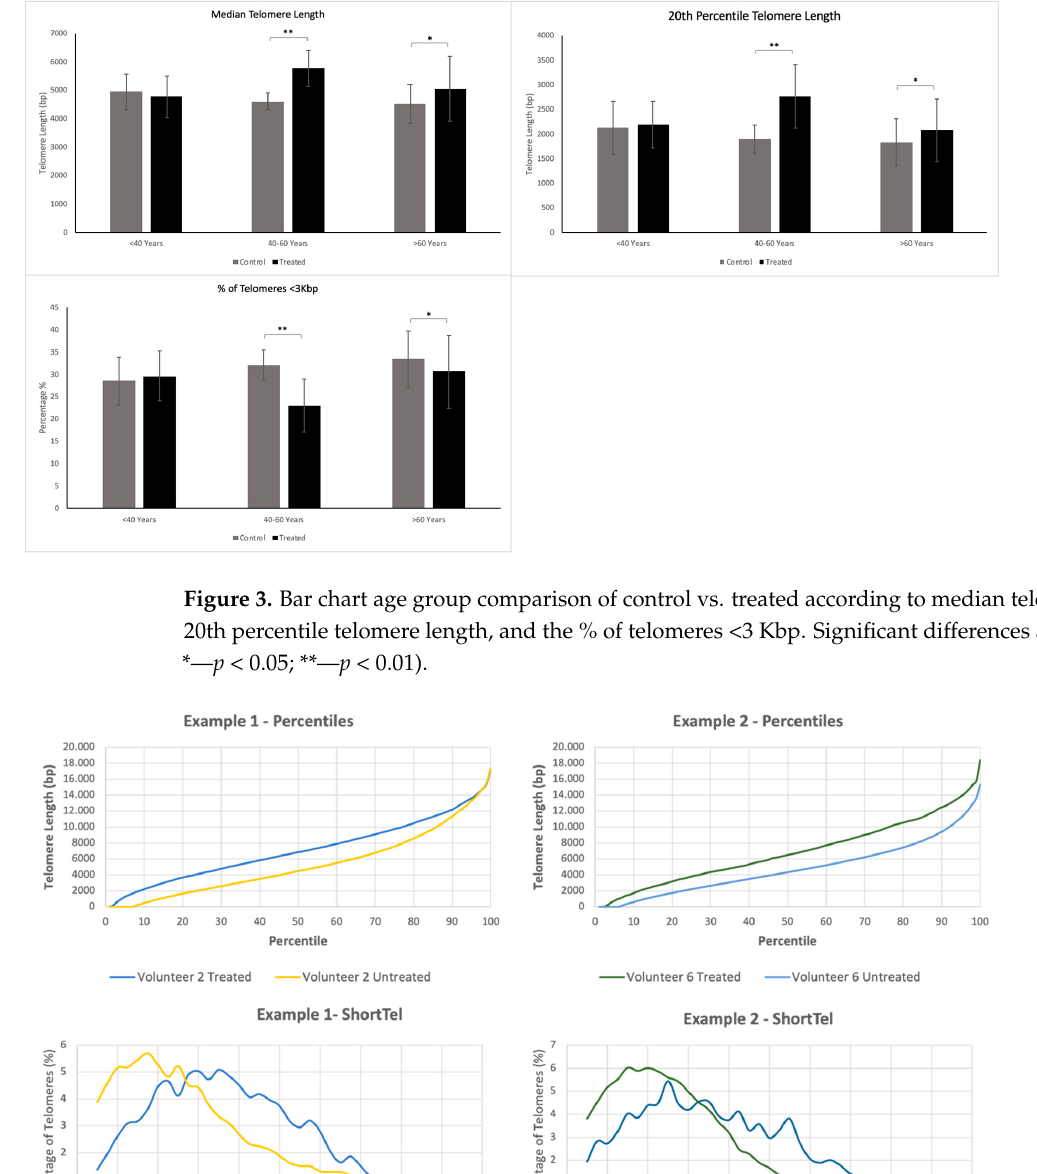
Figure 2. Bar chart comparison of control vs. treated (astragaloside 100 μ g/mL) samples after four weeks of in vitro expansion and under oxidative conditions. The variables compared are median telomere length, 20th percentile length, and the % of telomeres <3 Kbp. Significant differences are indicated: **— p < 0.01, ***— p < 0.001.